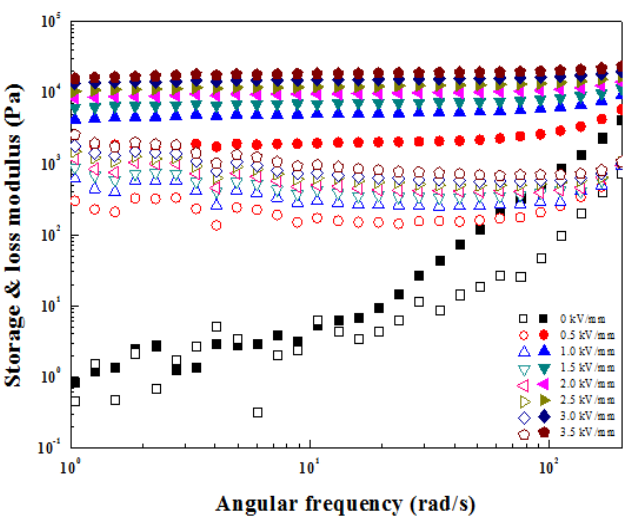
Figure 9. G (cid:48) (closed) and G” (open) in the frequency sweep measurement of ZnFe 2 O 4 /PMA-based Figure 9. G’ (closed) and G” (open) in the frequency sweep measurement of ZnFe 2 O 4 /PMA − based ER ER fluid.